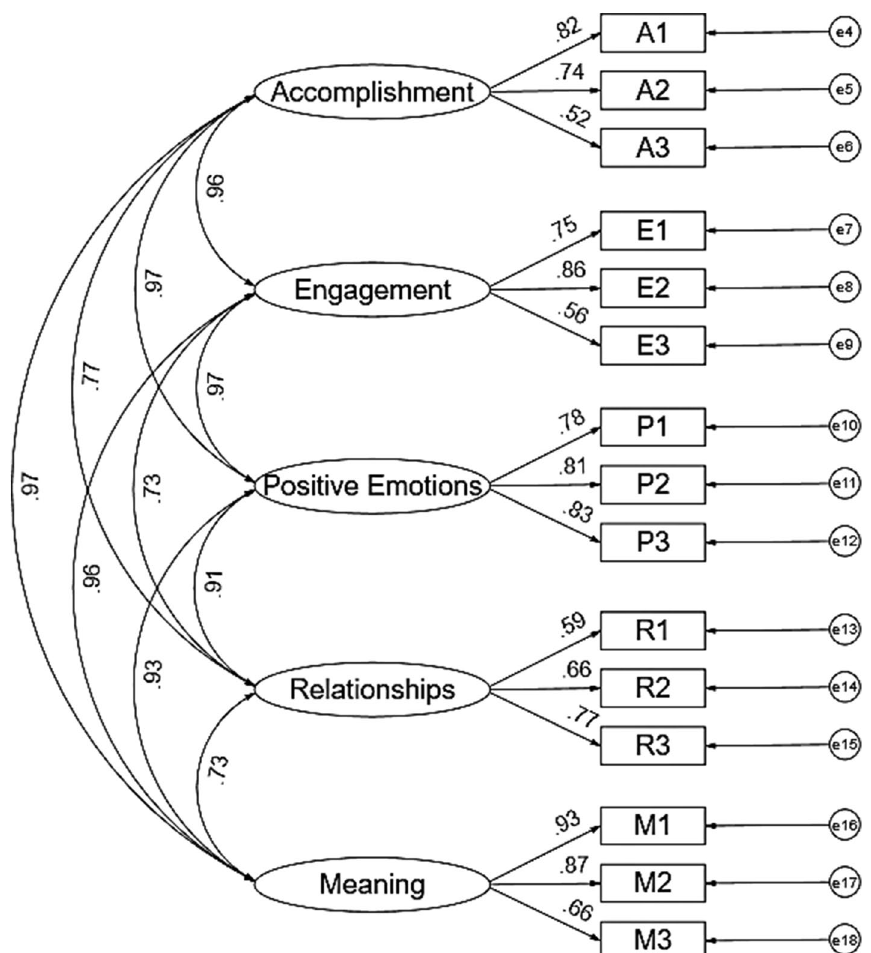
Fig. 1 Confirmatory factor analysis of PERMA-Profiler within the Palestinian context